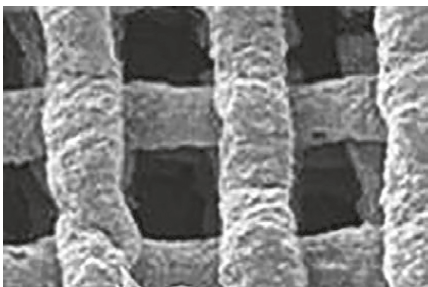
Figure 4: Flat mesh microstructure of the carbon nanotube